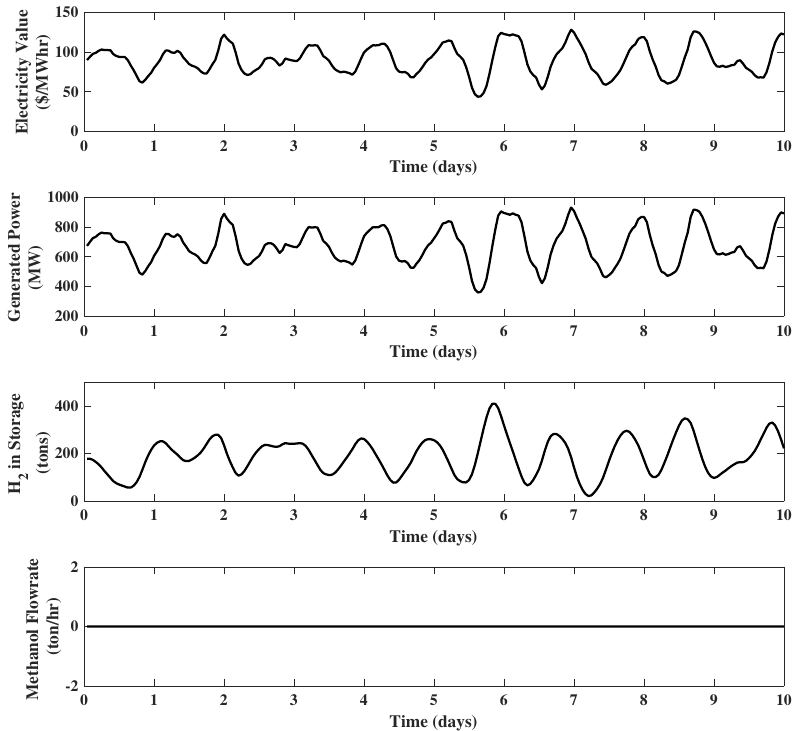
Figure 15. Value of electricity and the resulting power generation dispatch for the case of Σ C ( $20/MW h ) 2 and C = 100 $/ton MeOH. M